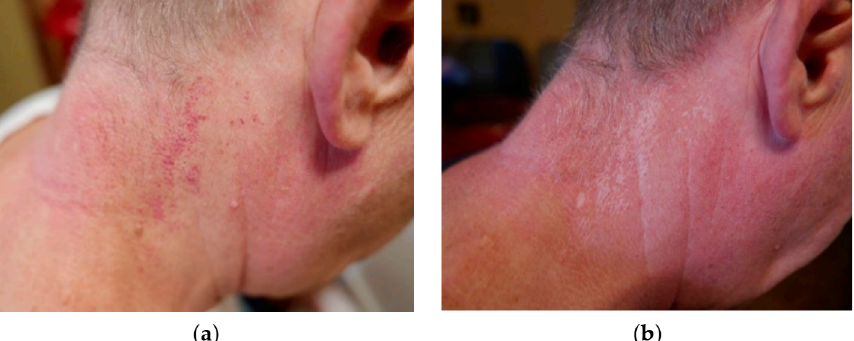
Figure 6. Red PWS on the neck: ( a ) before treatment and ( b ) after treatment (estimated at 9